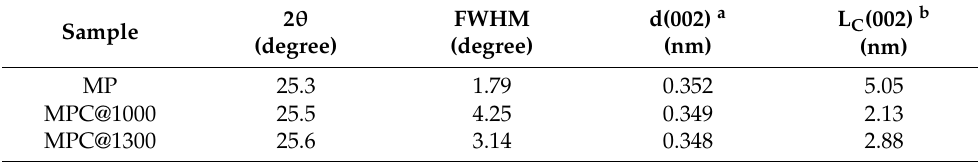
Table 1. The calculated structural parameters of different specimens from the XRD spectra.